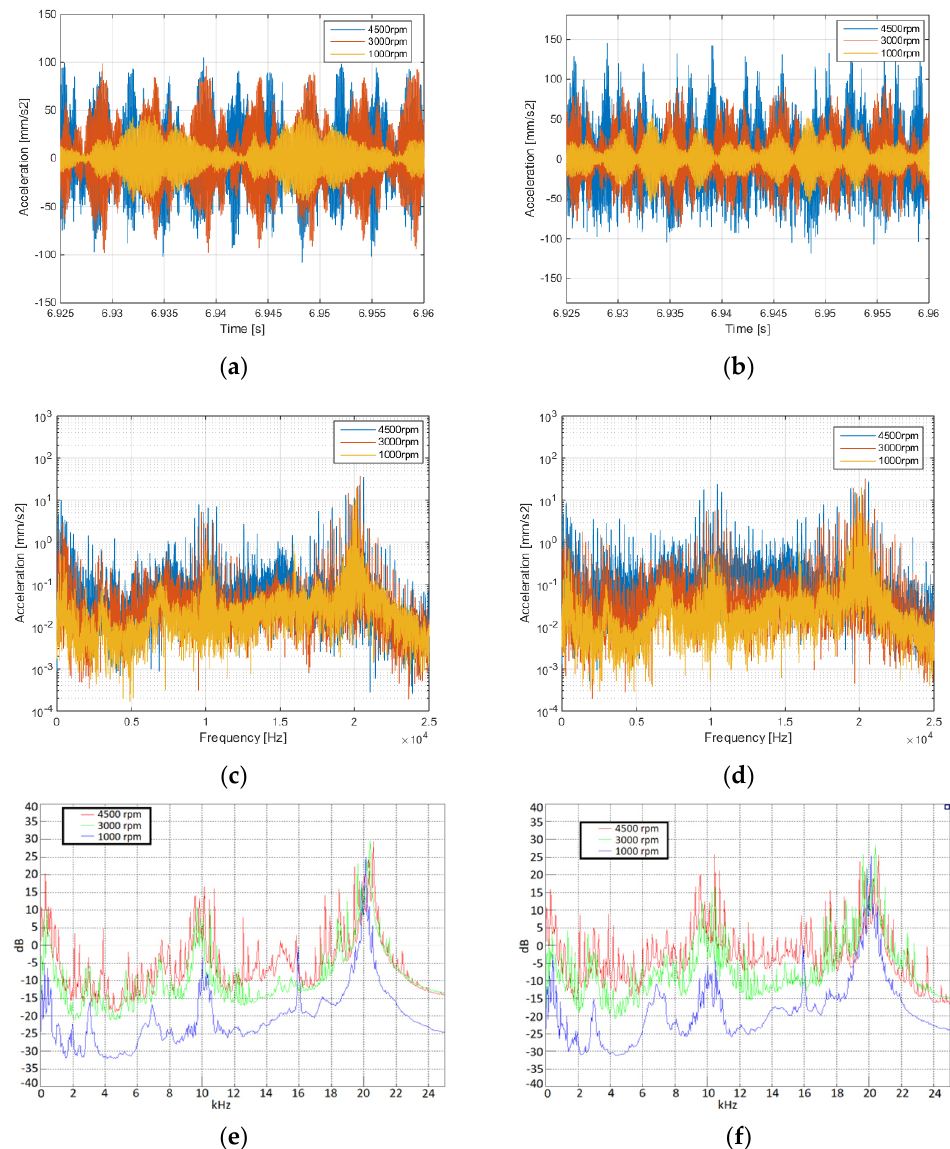
Figure 19. Vibration of the machine at various rotational speeds at 45 deg current angle: ( a ) 20 Nm— time waveform; ( b ) 60 Nm—time waveform; ( c ) 20 Nm—FFT; ( d ) 60 Nm—FFT; ( e ) 20 Nm—power spectrum; ( f ) 60 Nm—power spectrum.